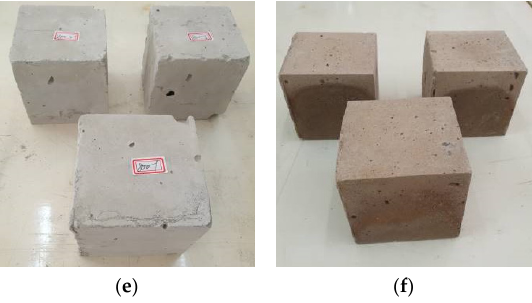
Figure 7. Appearance of cubic specimens after exposure to various temperatures: ( a ) 30 °C, ( b ) 200 °C, ( c ) 400 °C, ( d ) 600 °C, ( e ) 800 °C, ( f ) 1200 °C.